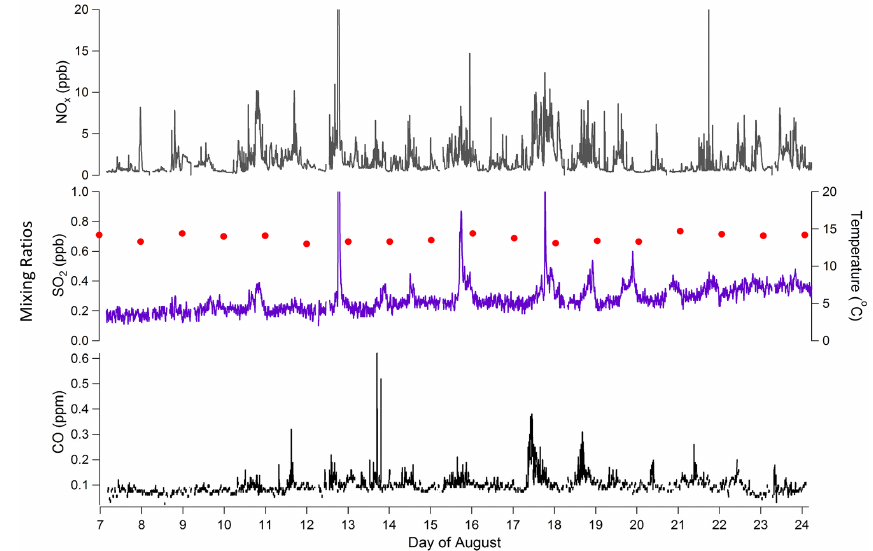
Figure 4. Time series (PDT) for 7–24 August of sea surface temperature (red circles), NO x (top), SO 2 (middle) and CO (bottom) mixing ratios.